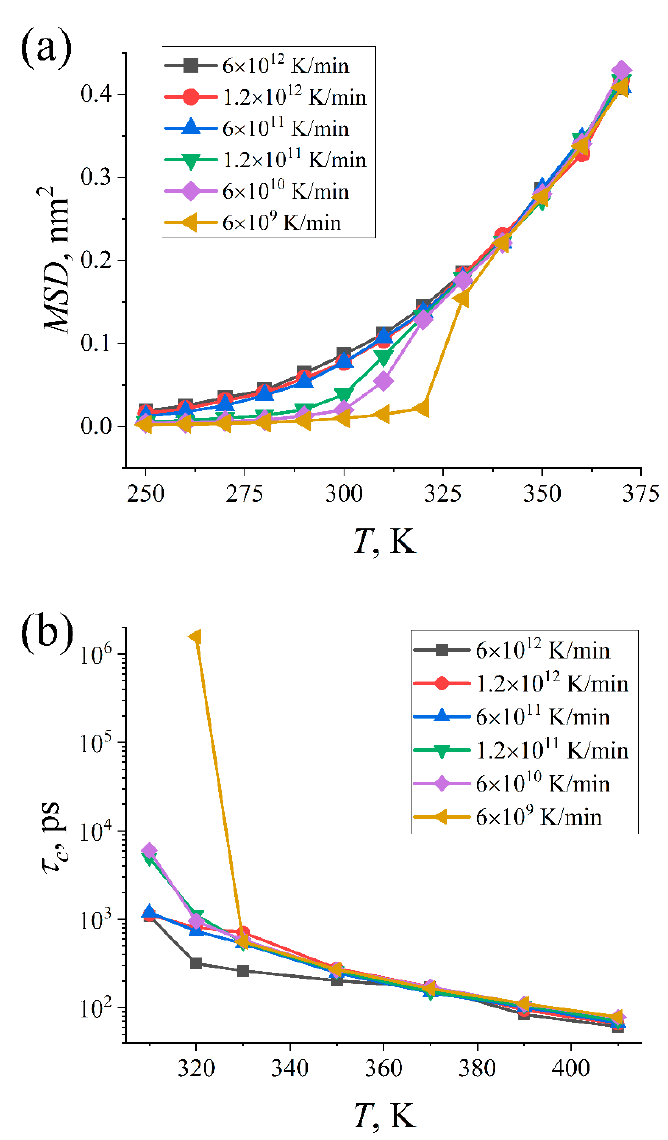
Figure 4. ( a ) Mean square displacements of paraffin molecules at a time interval of 80 ps as a function of temperature T . ( b ) The cumulative rotational relaxation time τ c of the C–C bond vector as a function of temperature T .